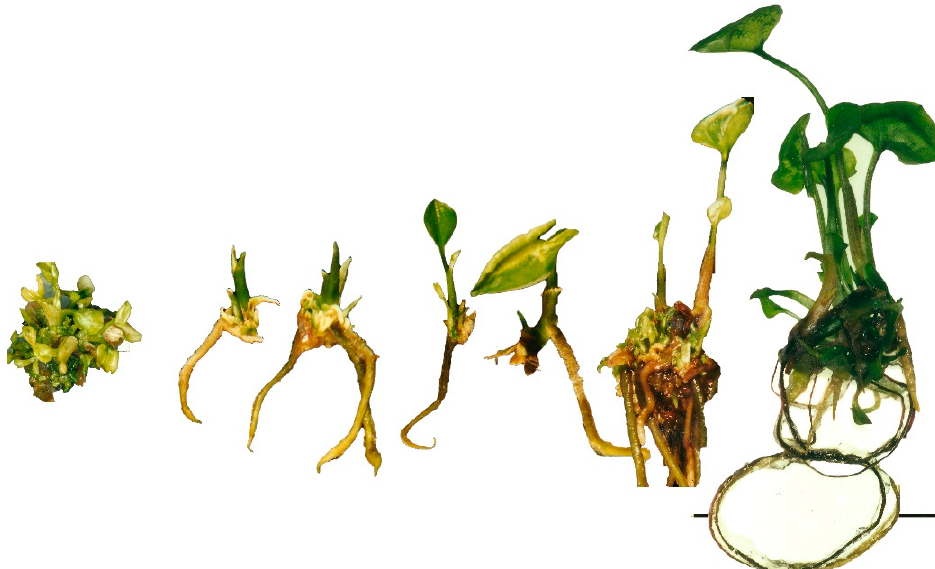
Figure 1. Different stages in the micropropagation of Syngonium podophyllum cv. ‘White Butterfly’. From left to right, de novo shoots over 7 mm in height were separately transferred to solidified MS62 culture medium for elongation of shoots up to the moment of transfer for acclimation. The culture medium’s composition is described in 2004 [33].